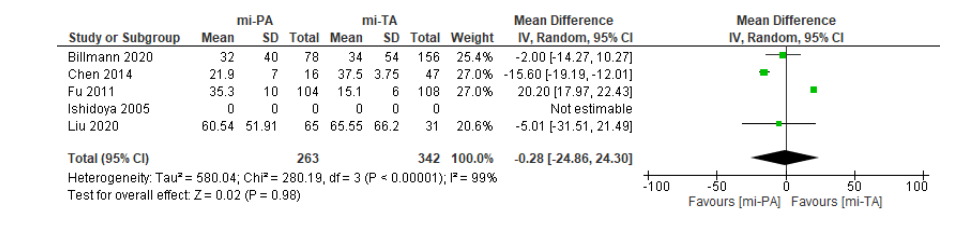
( c ) Forest plot representing analysis of mean blood loss.